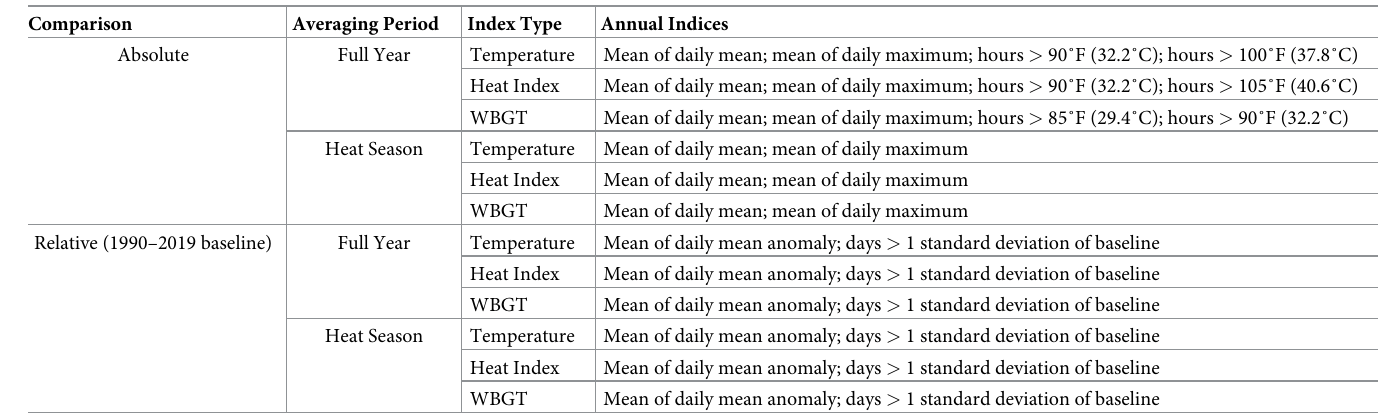
Table 1. Classification of included annual